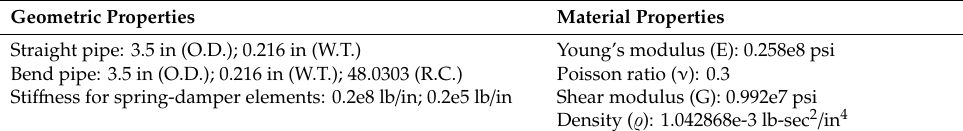
Table 1. Material properties and modeling information for NUREG/CR-1677 Benchmark piping system.